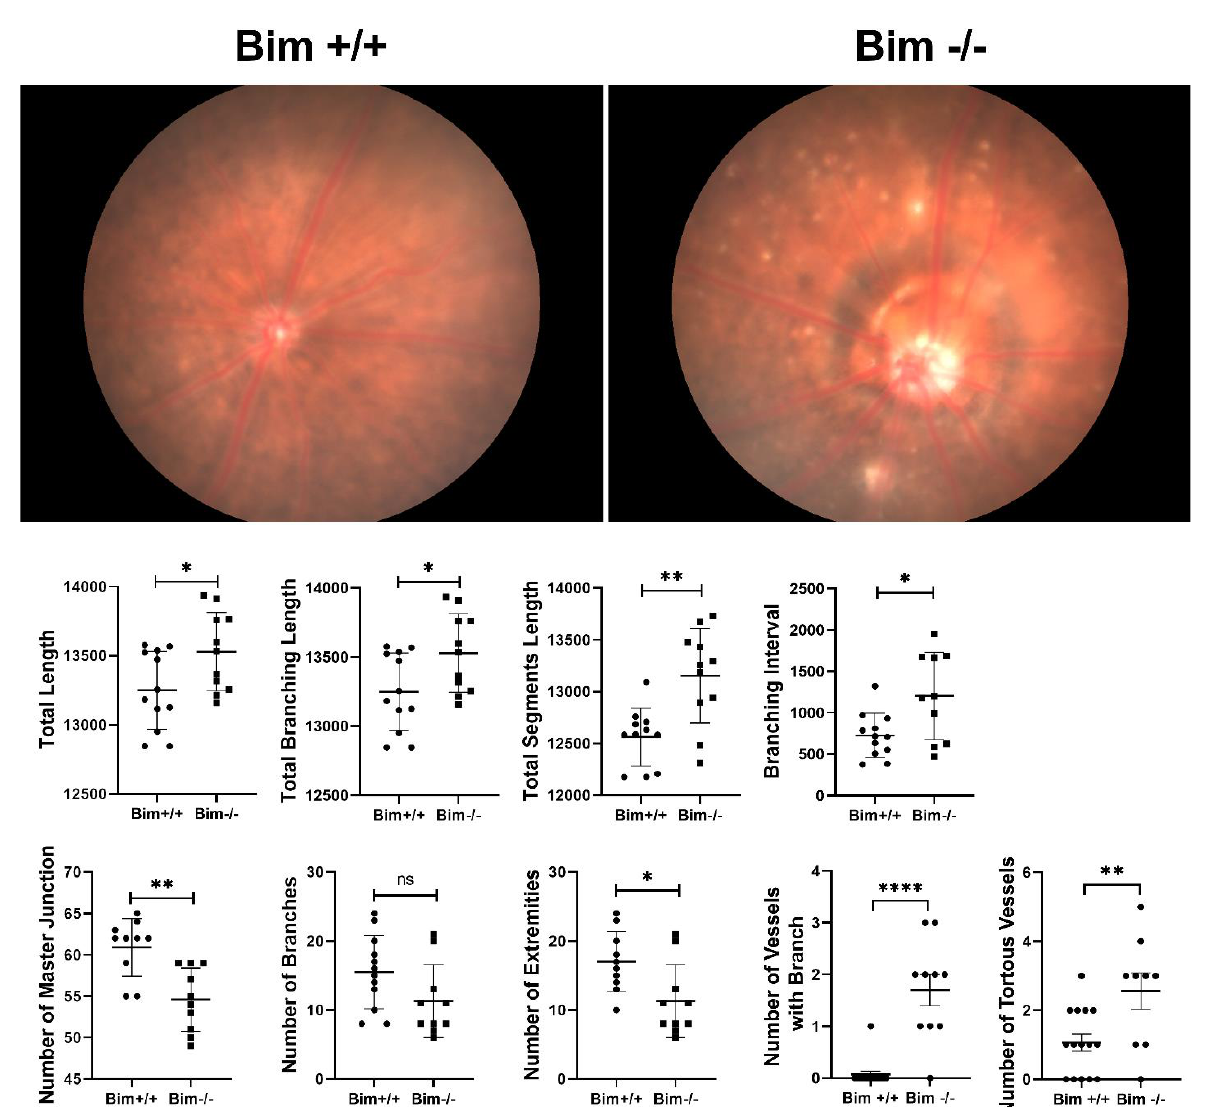
Figure 6. Increased retinal branching in the absence of Bim. Fundus imaging was performed on ten week-old Bim +/+ and Bim − / − mice utilizing a Micron III imaging system. The Canny Edge Detector and Angiogenesis Analyzer plug-in were used to analyze retinal microvascular branching characteristics. We also assessed branching or tortuous vessels visual on the superficial layer on the fundus image. Data representative of six mice. * p < 0.05, ** p < 0.01, and **** p < 0.0001, ns = not